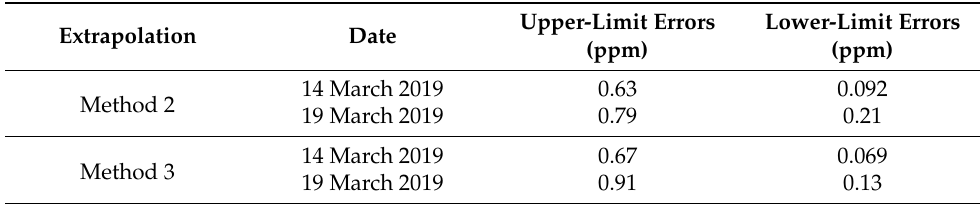
Table 5. The estimation of uncertainty for GOSAT induced by extrapolation Method 2 (GEOS-Chem CO 2 profiles) and Method 3 (CarbonTracker profiles).